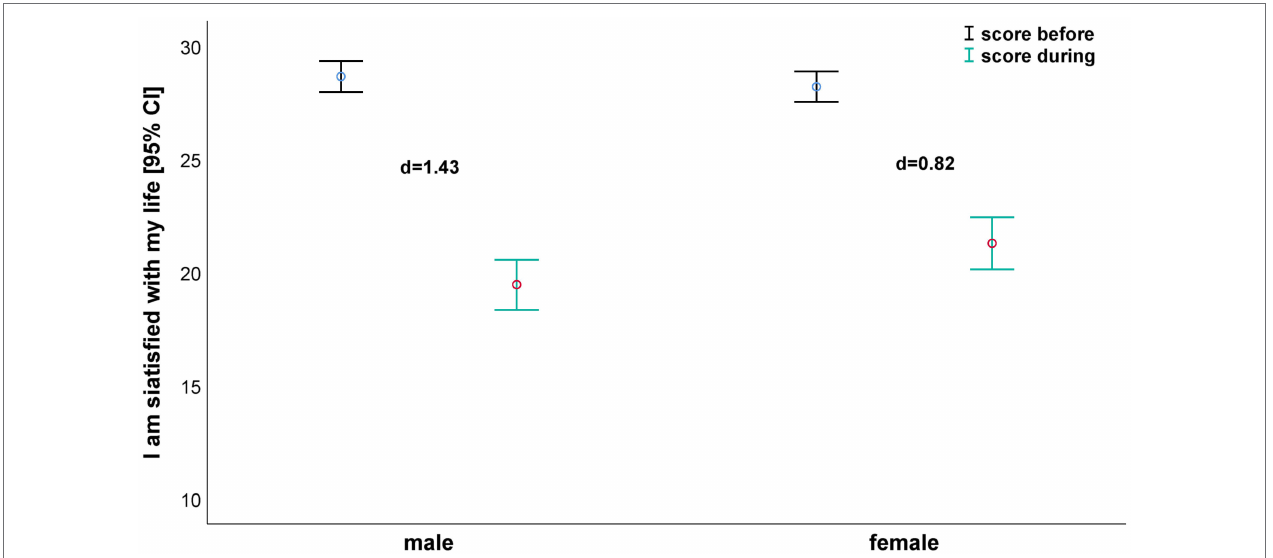
FIGURE 2 | I am satisfied with my life – depending on gender before and during